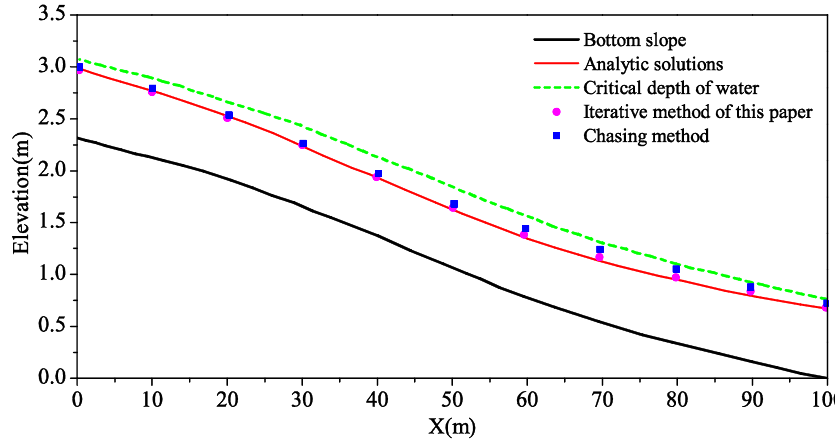
Fig. 12 Rapid flow example water surface: comparison between the calculated